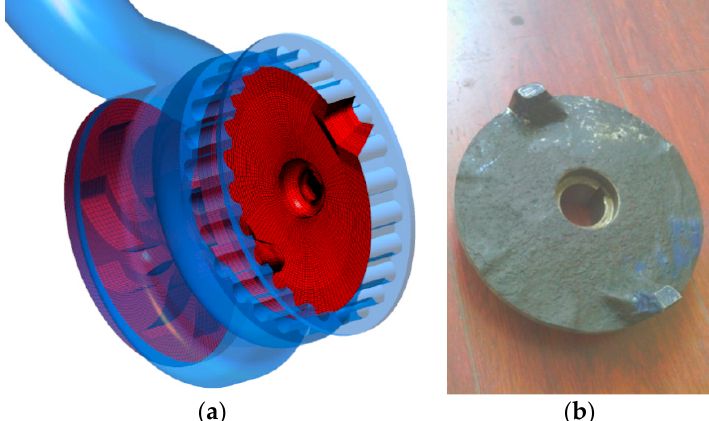
Figure 6. Water body assembly and test cutter. ( a ) Water body assembly, ( b ) Test cutter disk.